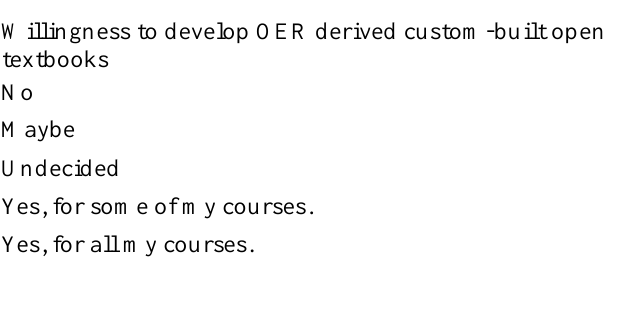
Motivators towards OER derived open textbook